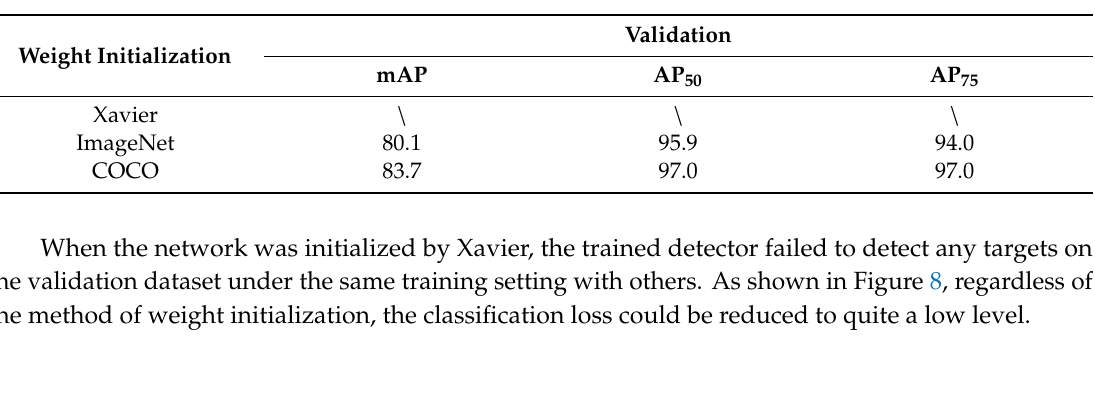
Table 4. Comparison of di ff erent methods of weight initialization on the validation